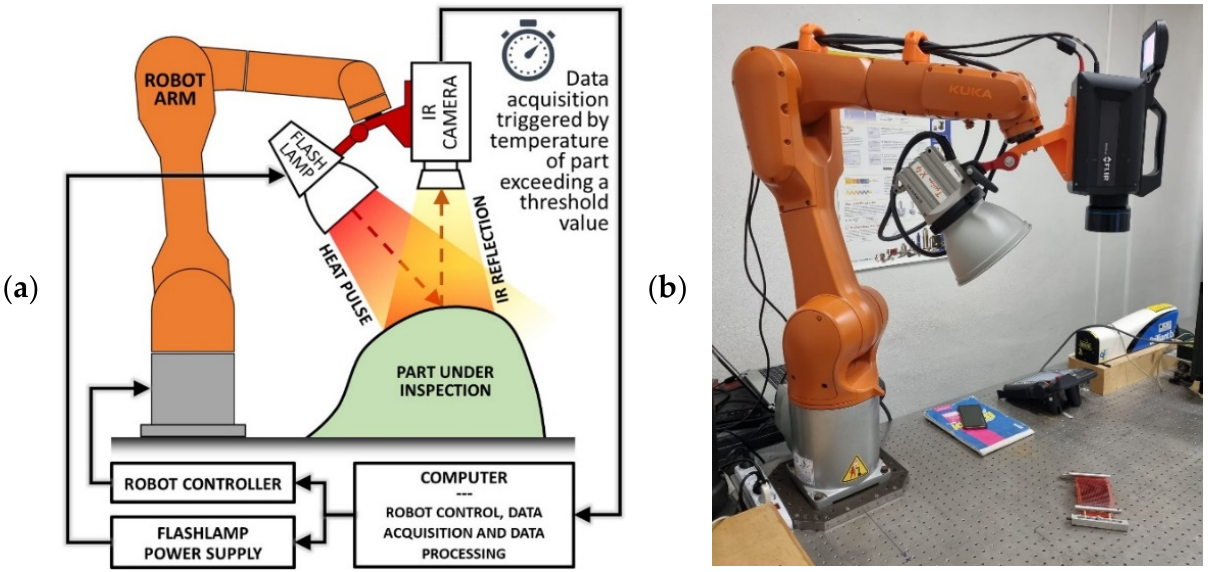
Figure 5. ( a ) Schematic representation of the robotic thermographic setup used in this work; ( b ) Photo of the actual laboratory setup.